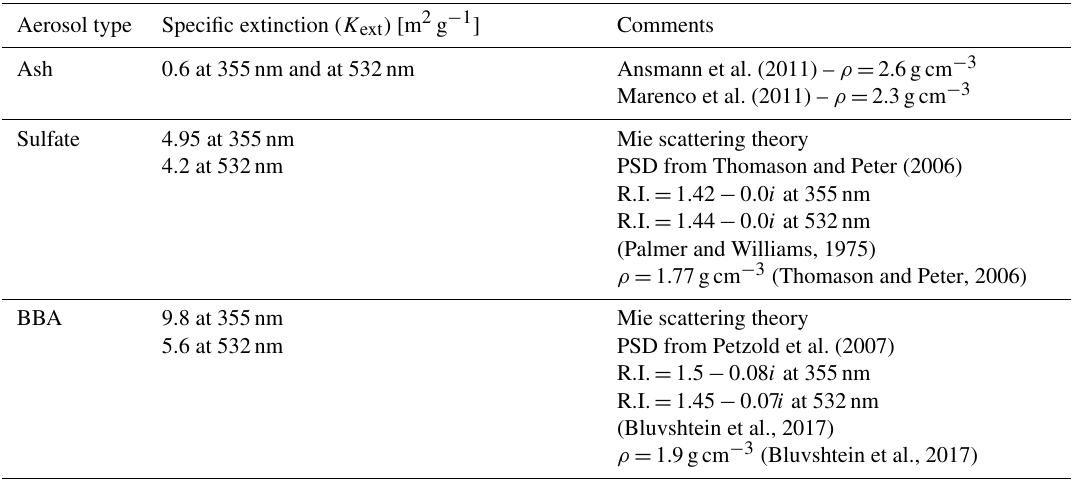
Table 3. Aerosol specific extinction values and assumed refractive indices (R.I.) and densities ( ρ ). Aerosol